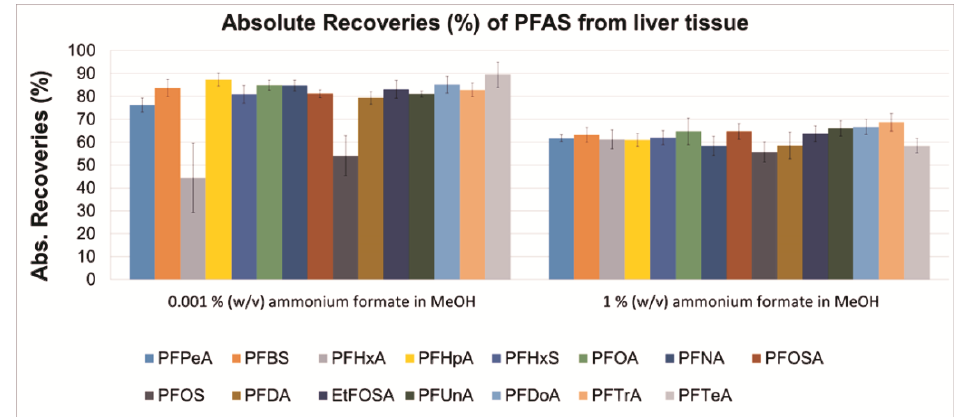
Figure 2. Absolute recoveries (%; N = 4) at the fortification amount of 10 ng on pooled harbour porpoise liver tissue with two different concentrations of ammonium formate in MeOH.